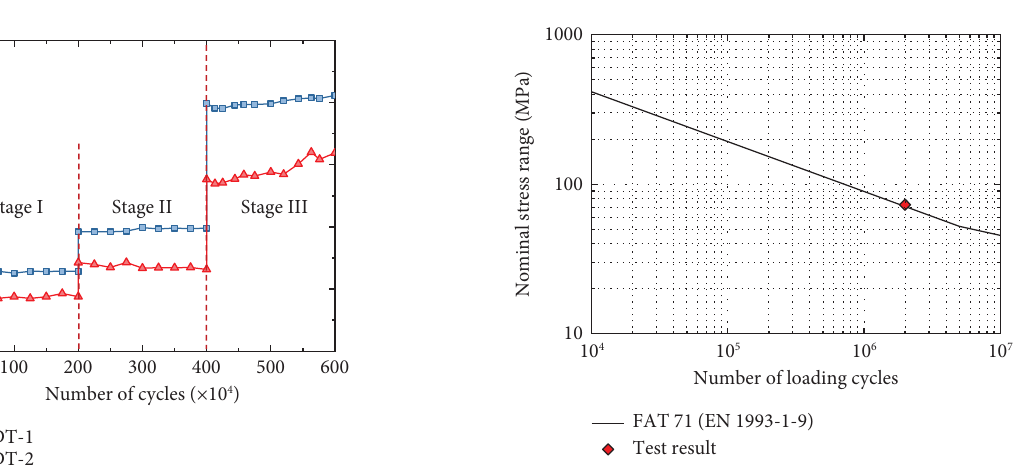
Figure 22: Fatigue strength of rib-to-deck and diaphragm